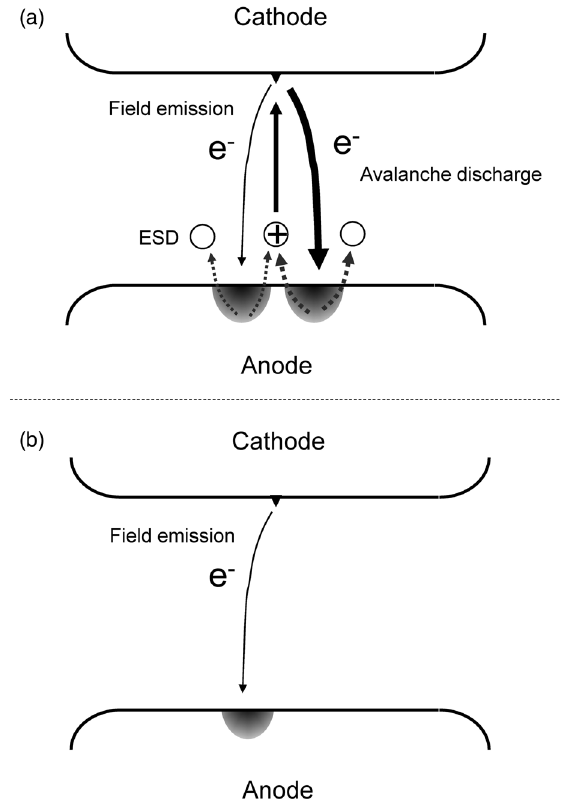
FIG. 10. (a) Avalanche discharge model. The field emission electrons generated from the cathode penetrate the anode surface layer, which results in electron stimulated desorption (ESD). A part of ESD is ionized and accelerated back to the cathode, which leads to the generation of secondary electron emission. The interplay between ESD and subsequent secondary electron emission can induce avalanche discharge. (b) When the electron beam energy is low, the source of ESD has been removed and discharge does not